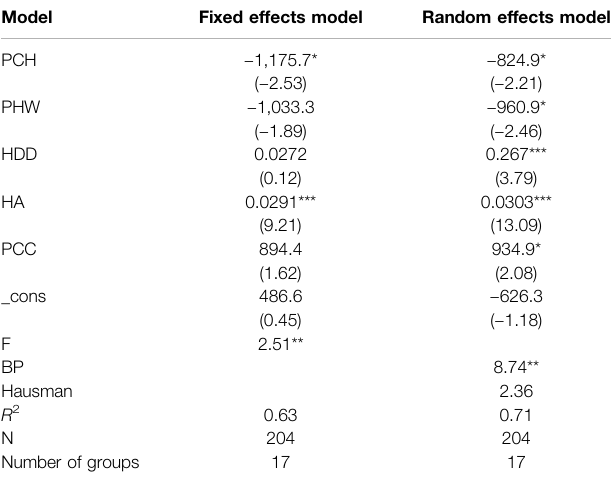
TABLE 2 | The main regression